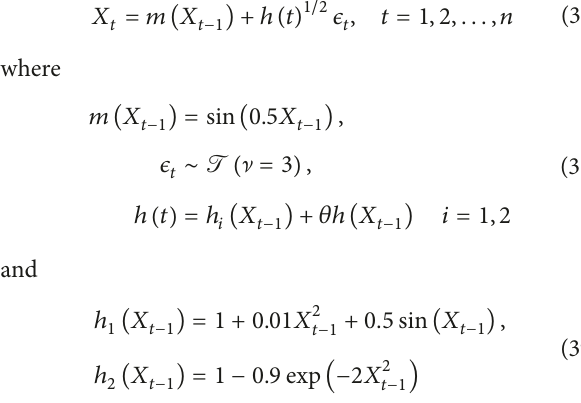
Nonparametric Prediction Interval for CVaR